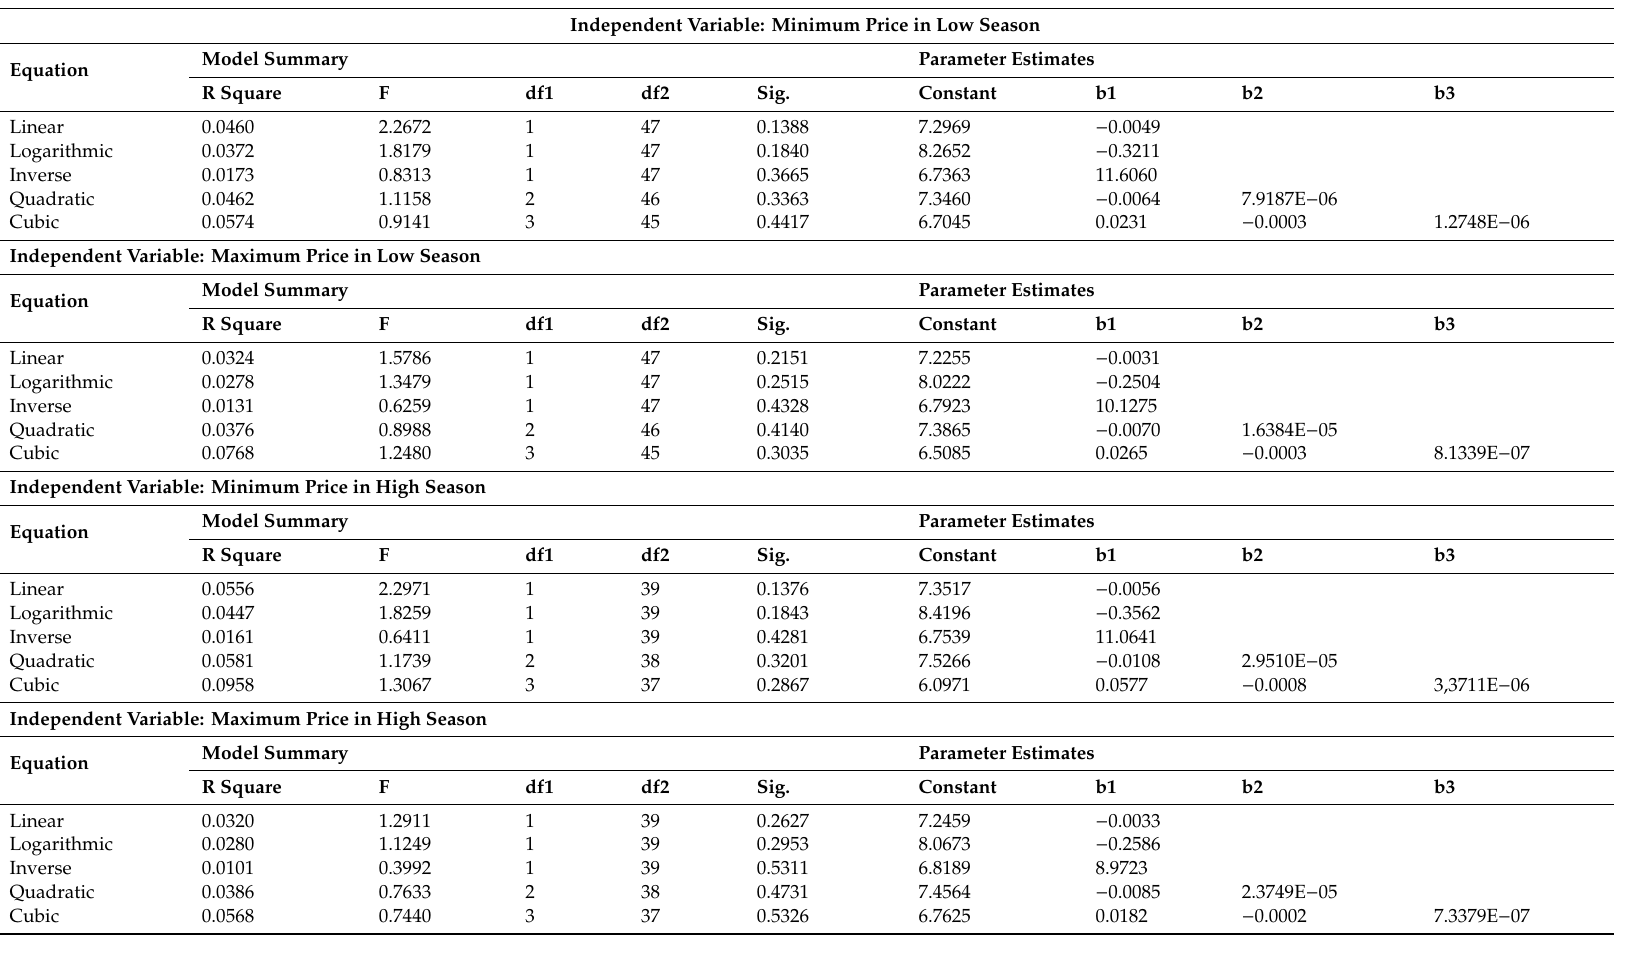
Table 11. Model summary and parameter estimates of regression analysis in Agadir destination with value as dependent